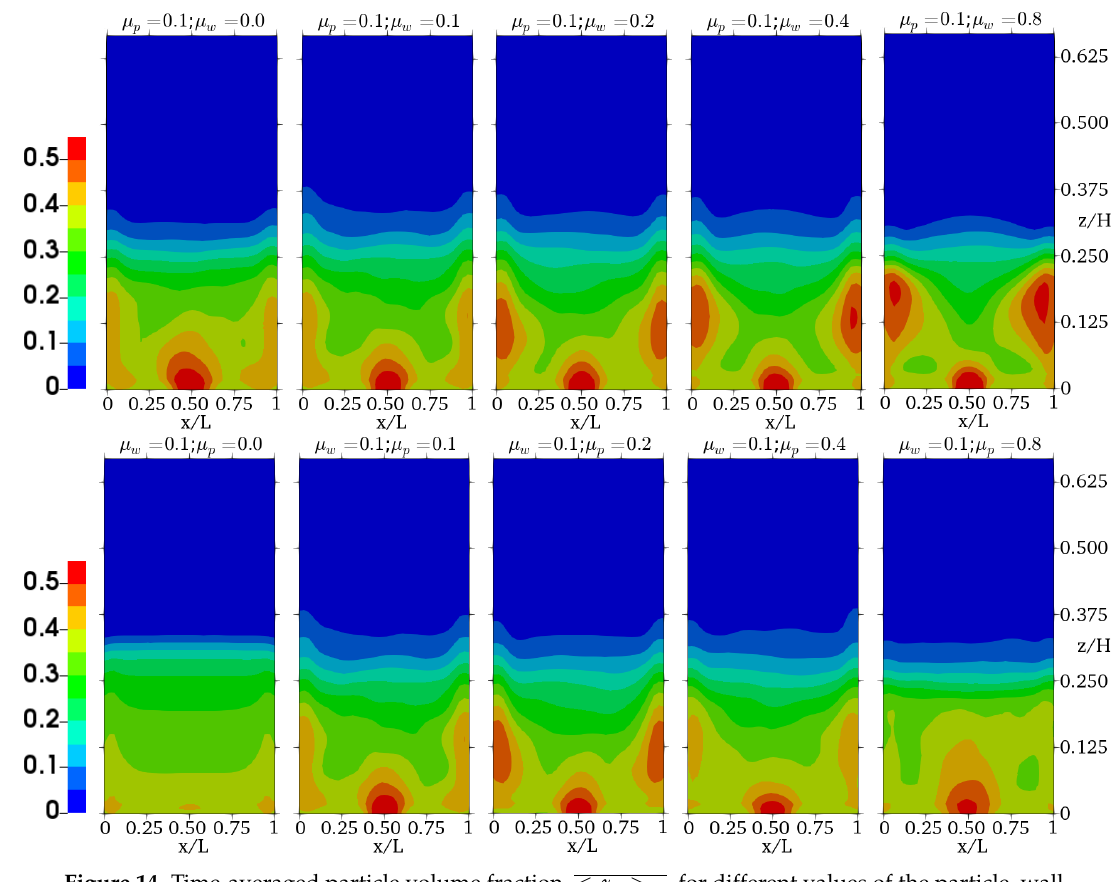
Figure 14. Time-averaged particle volume fraction, < α p > xz , for different values of the particle–wall µ w and the particle–particle µ p friction coefficients. Upper panel: constant µ p and different µ w . Bottom panel: constant µ w and different µ p . Re p = 70 and bed weight 75 g.